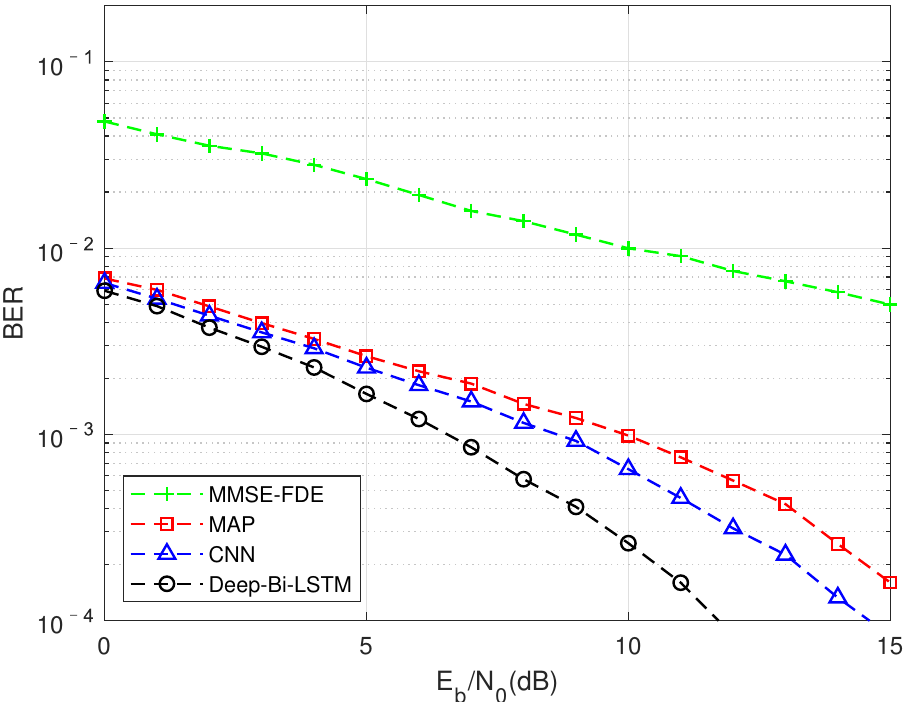
Figure 7. FTN detection performance results of different algorithm in the PB channel, MMSE equalization, and the compression factor τ =